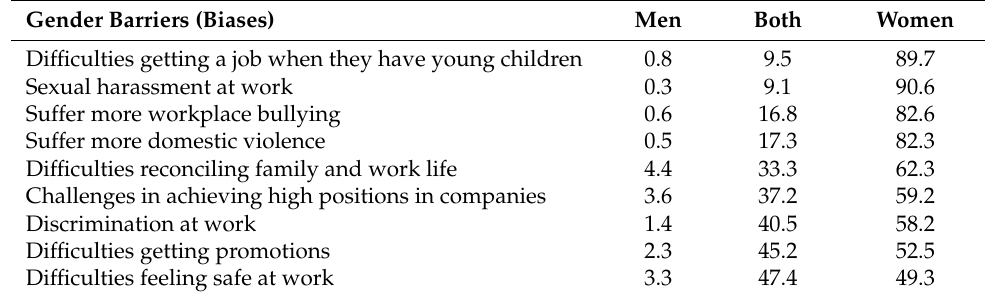
Table 5. Unperceived gender barriers (gender bias)